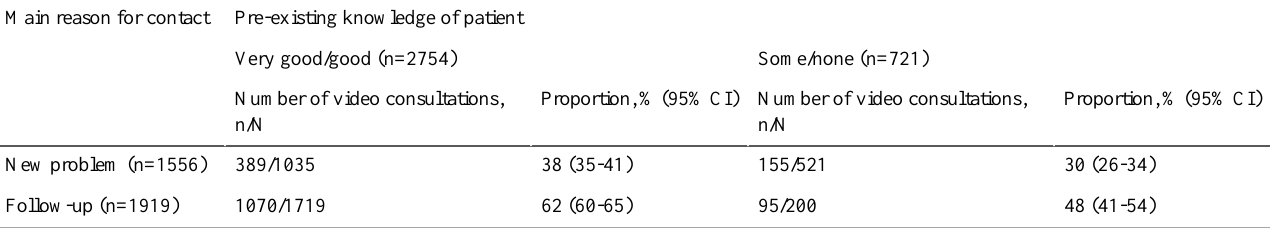
Table 3. Video consultations perceived by the GPs as equally or better suited compared to an envisaged face-to-face consultation, shown as combinations of pre-existing knowledge of the patient (relational continuity) and the main reason for contact (episodic continuity). Pre-existing knowledge of patientMain reason for